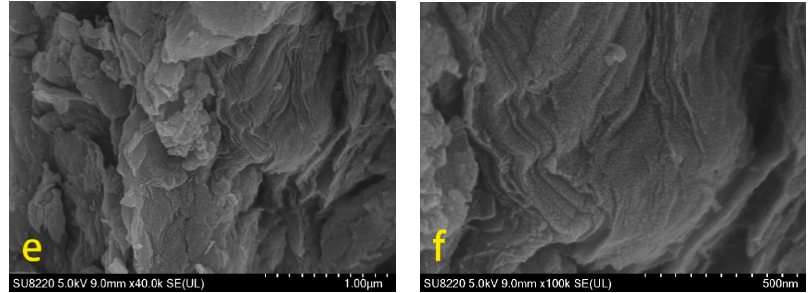
Figure 18. SEM analysis of GNPs ( a – c ) and GOs-SH ( d – f ).